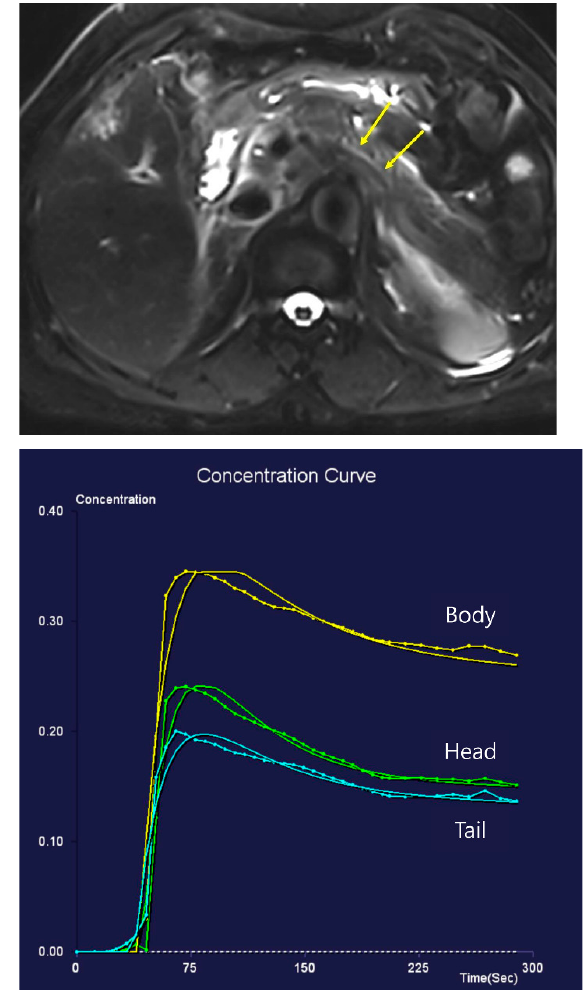
Figure 2. Seventy-one-year-old female patient undergoing an MRI to evaluate the gall bladder. There is no pancreatic dilatation (arrows) on the T2-weighted imaging ( a ) and no pancreatic focal lesion. Dynamic contrast-enhanced curves show rapid peak-enhancement and a gradual decrease in enhancement in the head, body, and tail ( b ).